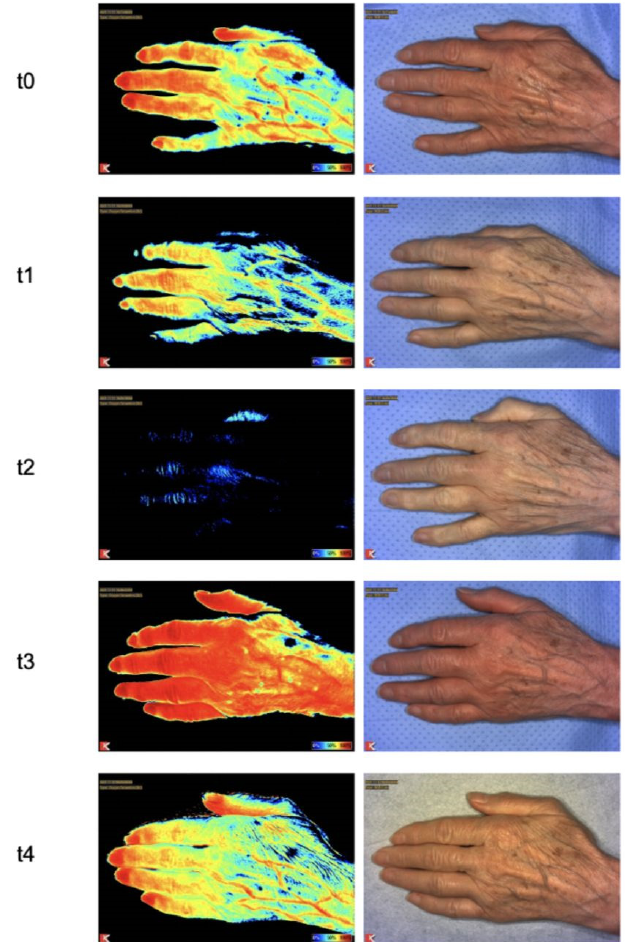
Figure 4. Mean values of measured tissue oxygen saturation at different timepoints.